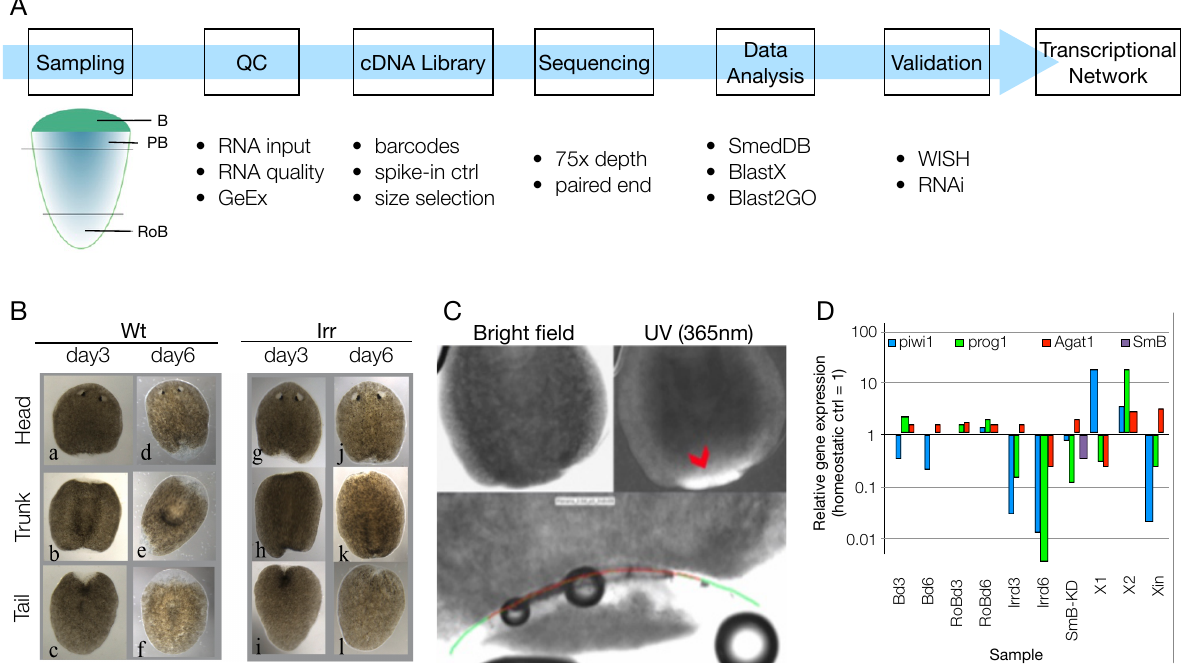
Figure 1. Experimental plan and sampling. ( A ) Schematics showing the experimental setup and the main techniques used to generate the shortlist of transcription factors involved in the anterior blastema regeneration. ( B ) Wild-type (a–f) and irradiated (g–l) animals 3 and 6 days after amputation in three fragments: head, trunk, and tail. ( C ) Day 3 wt trunk fragment under bright field and UV light illumination. The blastema is highly refractive under UV light, allowing the precise definition of the laser cut path (bottom). Red arrowhead: blastema-postblastema boundary; green line: laser cutting path (1st); red line: laser cutting path (2nd). ( D ) After RNA extraction and cDNA synthesis, the array of samples used in the study were assessed via qPCR for smedwi1, prog1 , Agat1 , and SmB (shown for SmB -KD sample